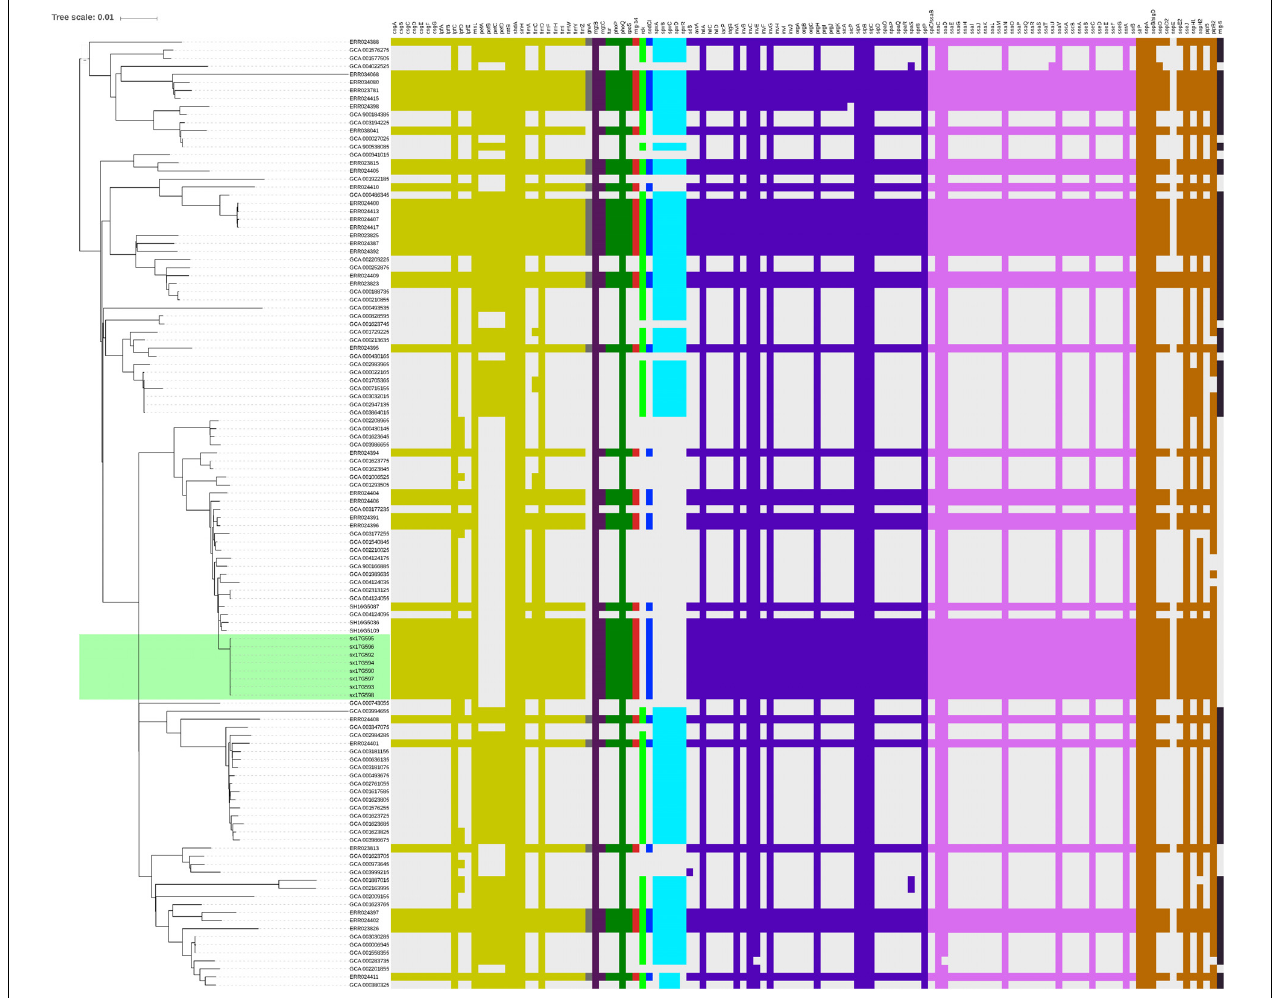
FIGURE 5 | Virulence gene analysis of S . Typhimurium strains. Heatmaps were generated by aligning the draft genome sequence of each stain to the virulence gene database. Presence of virulence genes is represented by different color boxes with different kinds of virulence genes, whereas absence of virulence genes is represented by a light gray box. The following gene groups were represented by the respective color-coded boxes, as follows: adherence-related genes by dark yellow, antivirulence-related genes by dark gray, magnesium uptake-related genes by dark purple, regulation-related genes by dark green, resistance to antimicrobial peptides genes by dark red, serum resistance genes by light green, stress protein genes by dark blue, toxin related-genes by light blue, SPI-1 genes by blue-violet, SPI-2 genes by plum, macrophage-inducible genes by black and other virulence genes by